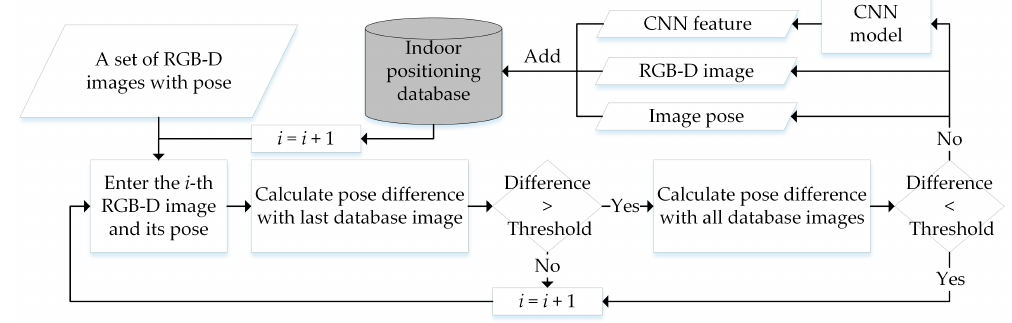
Figure 4. Flowchart of the proposed indoor positioning database construction process.